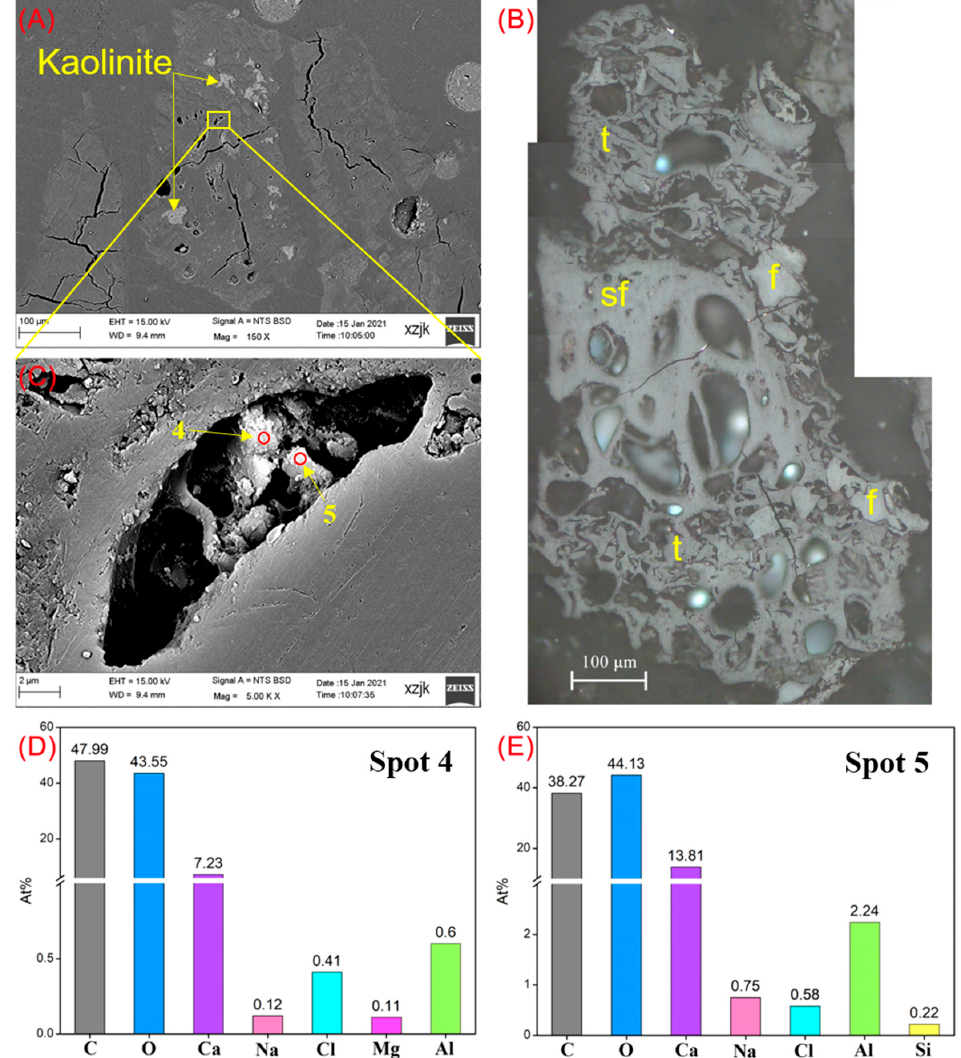
Figure 7. Microscope and SEM–EDS identification of DLTI: ( A ) SEM image of ( B ); ( B ) A particle sandwiched by two pieces of telinite (t) and a semifusinite (sf) bulk; ( C ) Magnified SEM image of the yellow-boxed area in ( A ); ( D , E ) are EDS spectra from Spots 4 and 5, respectively.